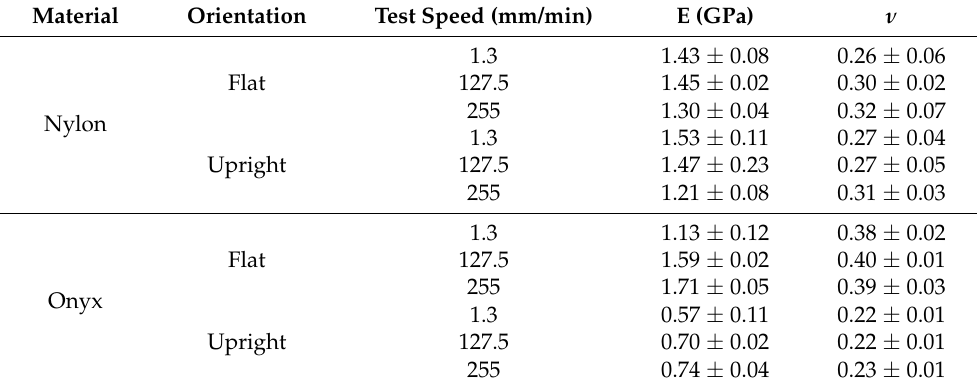
Figure 12. Variation of compressive properties of nylon with strain rate and orientation: ( a ) compres- sive modulus and ( b ) Poisson’s ratio. Table 3. Compressive properties of nylon and Onyx: compressive modulus (E) and Poisson’s ratio ( ν ).